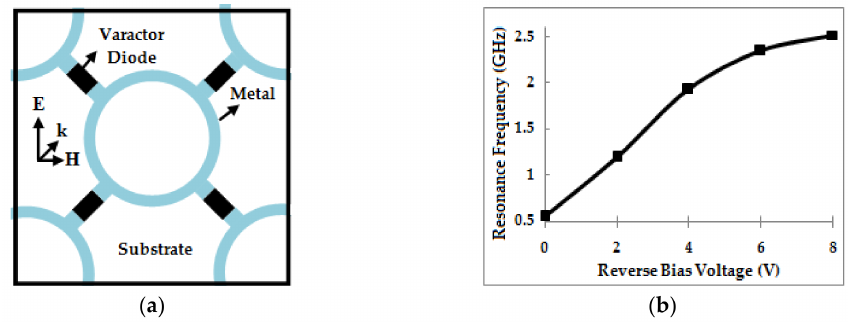
Figure 19. ( a ) Fabricated two-dimensional (2D) array AFSS structure. ( b ) Effect on resonance frequency under different reverse bias voltages measured by parallel plate waveguide.